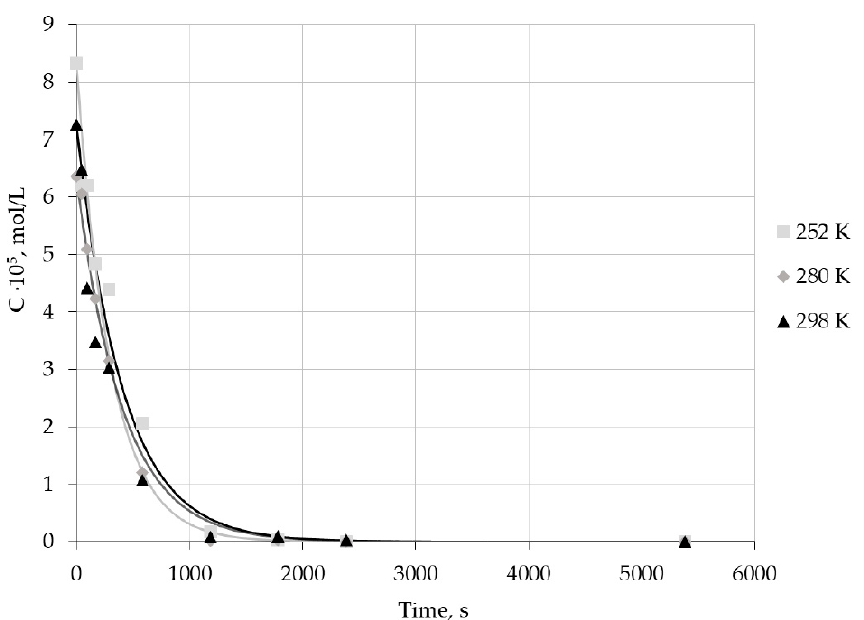
Figure 3. The dependence of the H 2 S concentration change on the time of sorption on ferroman- ganese material at different temperatures.